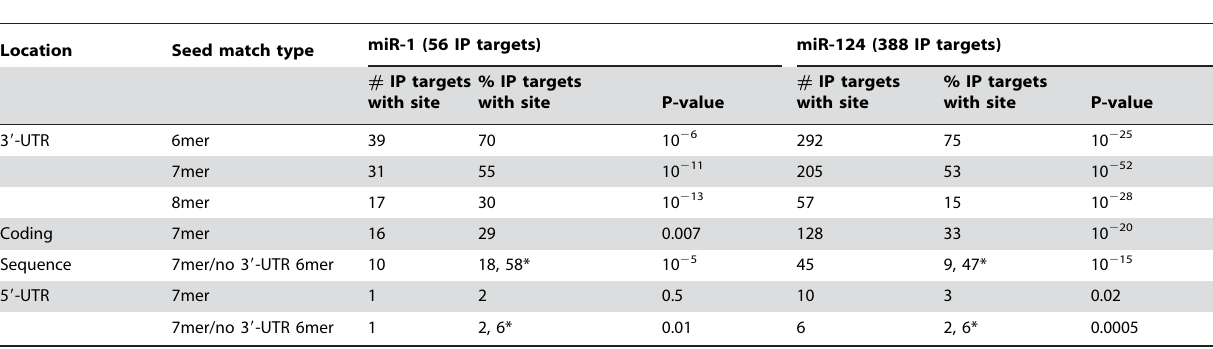
Table 1. Enrichment of seed match sites to miR-1 and miR-124 in Ago2 IP targets (1% local FDR).